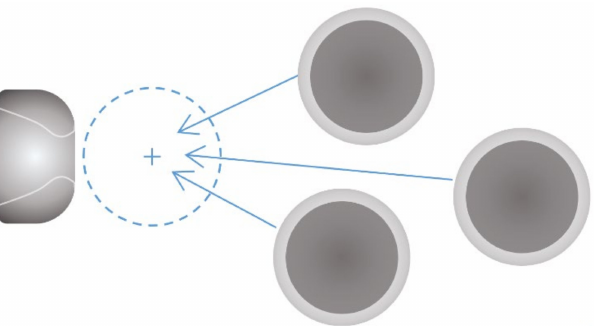
Figure 4. Schematic: Transferring the selected oocyte to the specified position near the holding micropipette for